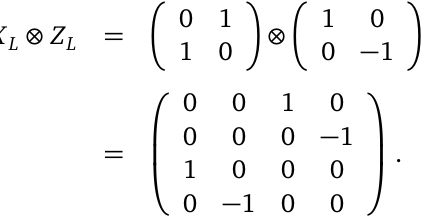
Figure 35: Braid transformation of a single Z-cut qubit. (a) Z-cut qubit with the operator X showing the three data qubits that define the operator. (b) Extended opening (heavy grey) for first move in the braid. Data qubits isolated by the extension are measured in X with outcomes X e ,..., X e . (c) The X operator (blue, dark) is extended to X (cid:48) L 1 8